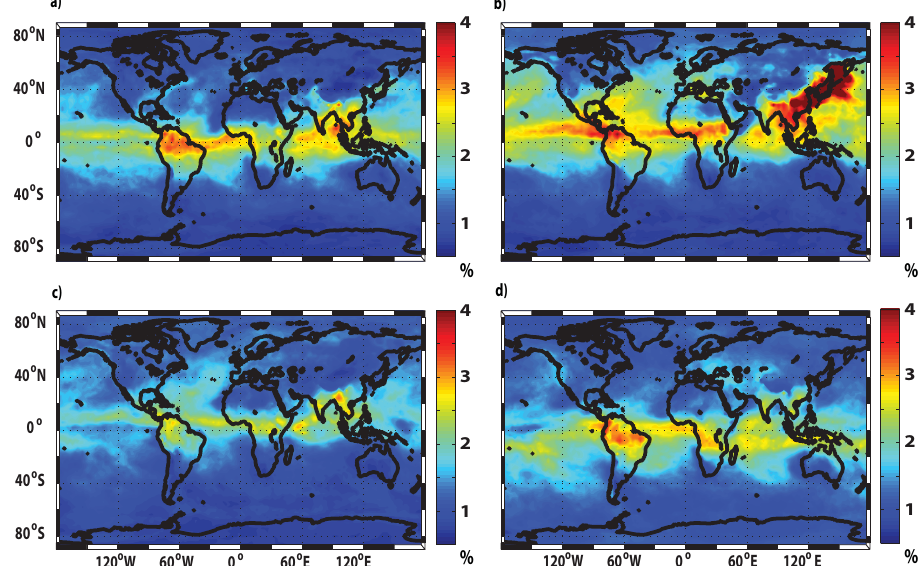
Fig. 4. Model-predicted seasonally averaged DIF values (%) in deposited mineral dust for (a) March–May (MAM), (b) June–August (JJA), (c) September–November (SON), and (d) December–February (DJF).